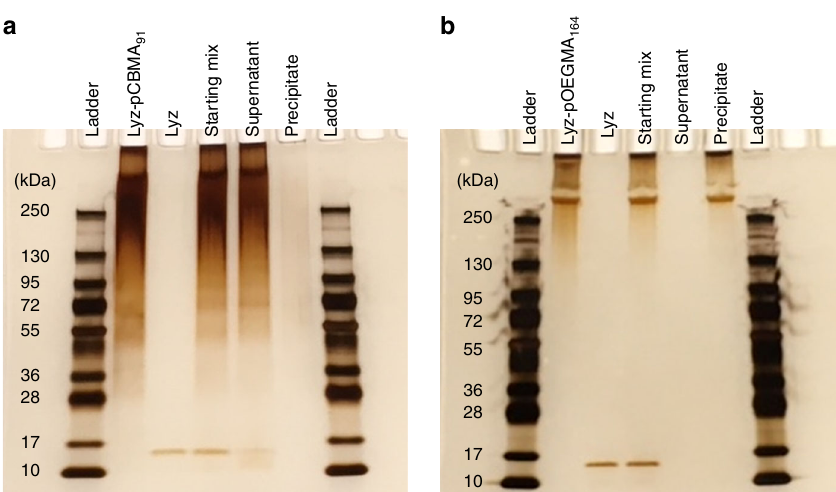
Fig. 5 Puri fi cation using SDS-PAGE analysis. Silver stained SDS-PAGE gels to show puri fi cation of a mixture of native Lyz and a Lyz(5 + )pCBMA DP 91 or b Lyz(5 + )pOEGMA DP 164. Samples were mixed in a 1 to 99 volume ratio of native Lyz to conjugate (starting mix) and ammonium sulfate was added to preferentially precipitate native Lyz from Lyz-pCBMA (100% saturation) or to precipitate Lyz-pOEGMA from native Lyz (40% saturation). Supernatants and precipitates were dialyzed in deionized water to remove salt and were then concentrated back to starting concentrations using ultra fi ltration prior